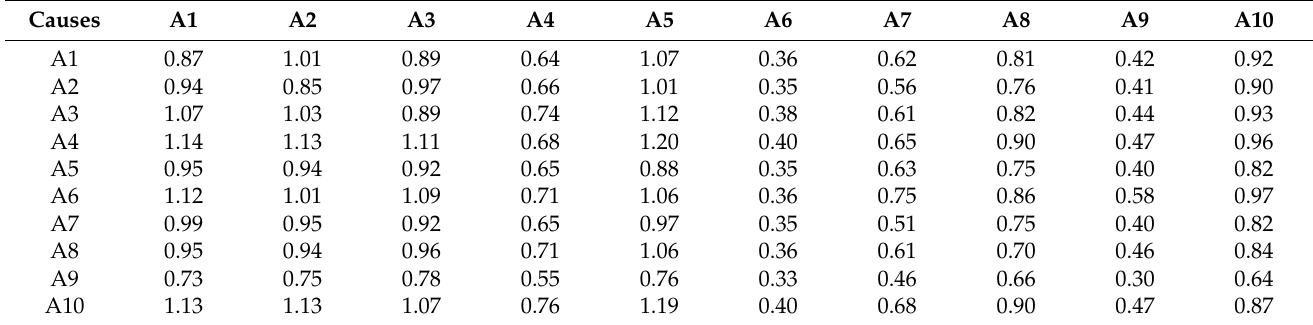
Table 4. Structure of total impact for porosity cluster on the mechanical